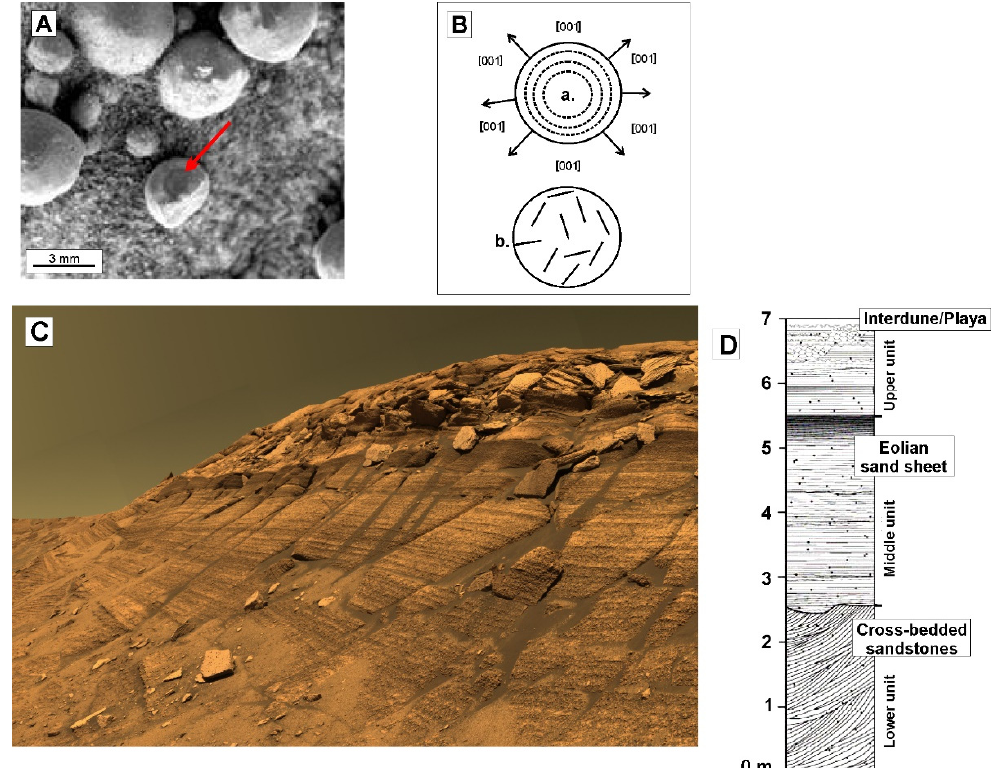
Figure 2. Internal structure of Martian spherules and overview of the Burns Formation exposed at Meridiani Planum. ( A ) Presence of a possible nucleus in a spherules (see red arrow), image acquired by the Microscopic Imager on NASA’s Mars Opportunity rover; spherule is about 3 mm in diameter (Sol 1216). ( B ) Internal fabric of a modeled haematite-spherule (a) revealing concentrically grown anhedral haematite crystals with a lattice preferred orientation dominated by [001] axis emission and a modeled spherule (b) composed of concentrically grown anhedral haematite crystals (after Glotch et al., 2006) [26]. ( C ) Exposure of the Burns Formation at Burns cliff on the southeast rim of Endurance crater; image by the Panoramic Camera on NASA’s Mars Opportunity rover. ( D ) Stratigraphy of the Burns Formation, modified from Grotzinger et al. [12].